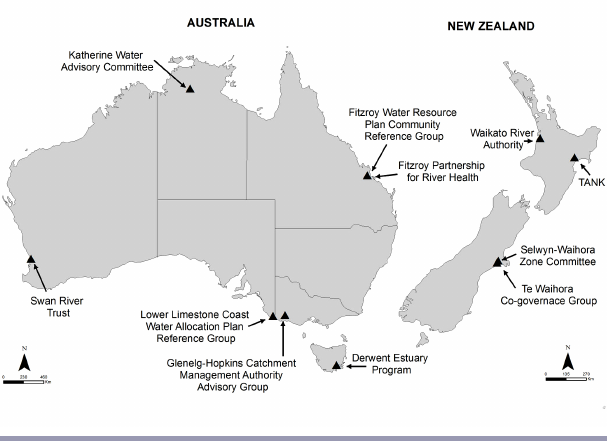
Fig. 1 . Location of the 11 collaborative